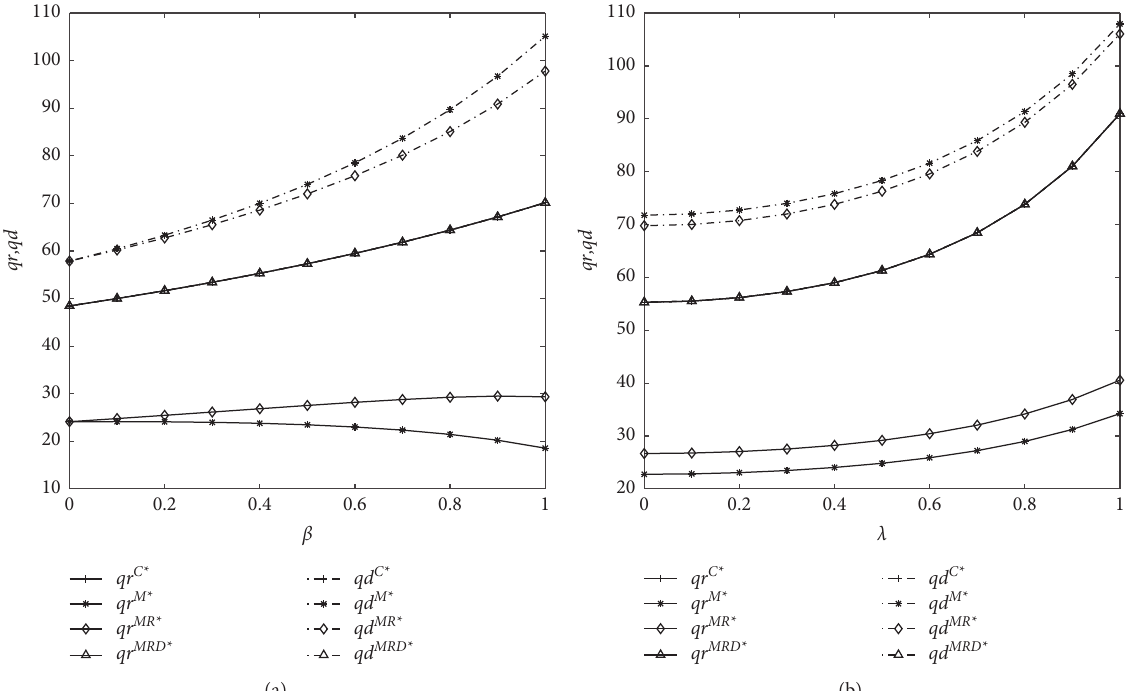
Figure 3: The effect of β and λ on online and offline channel demand.